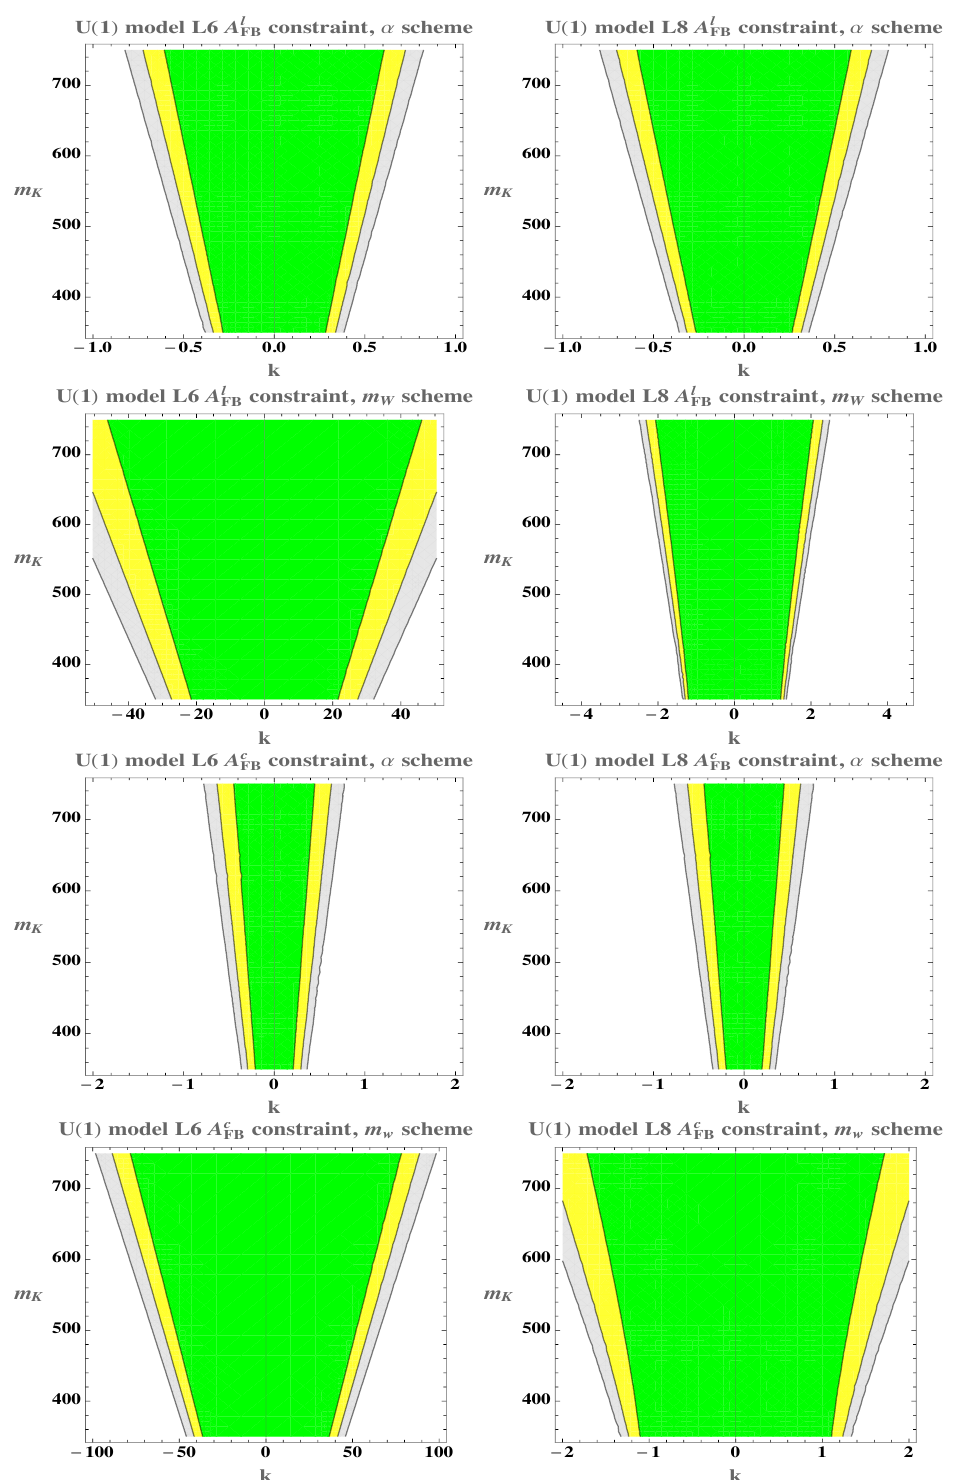
Figure 6 . Shown are the constraints on the model space from the A ‘